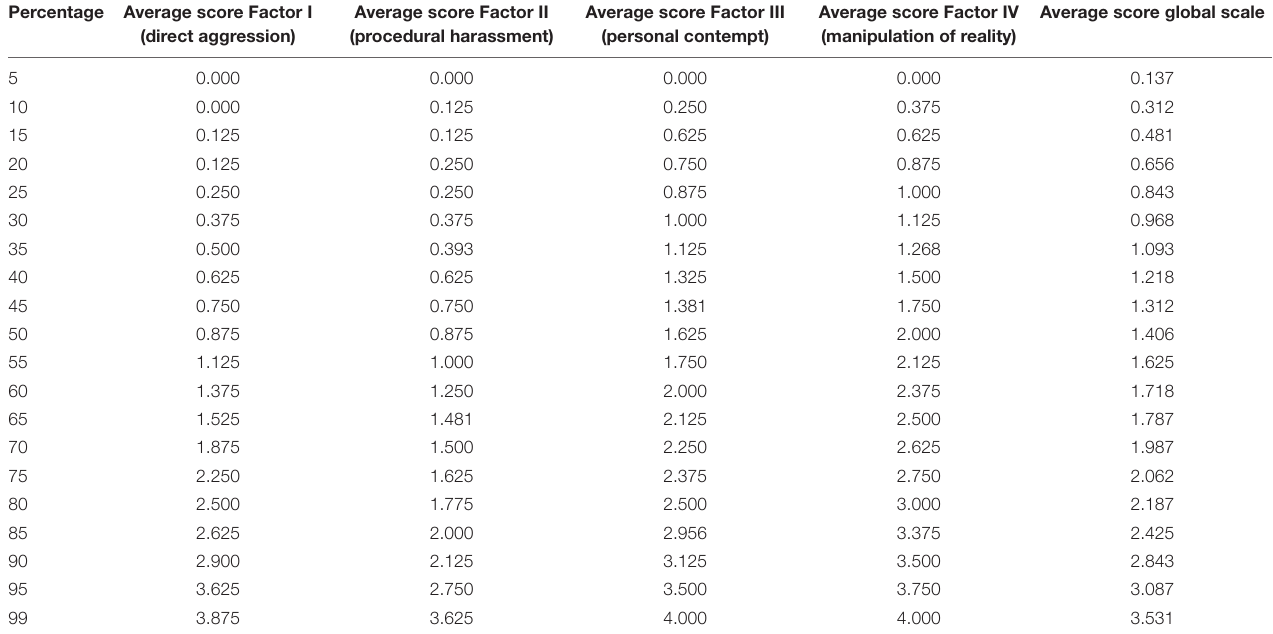
TABLE 2 | Scores for the Legal Harassment Scale. Percentage Average score Factor I (direct